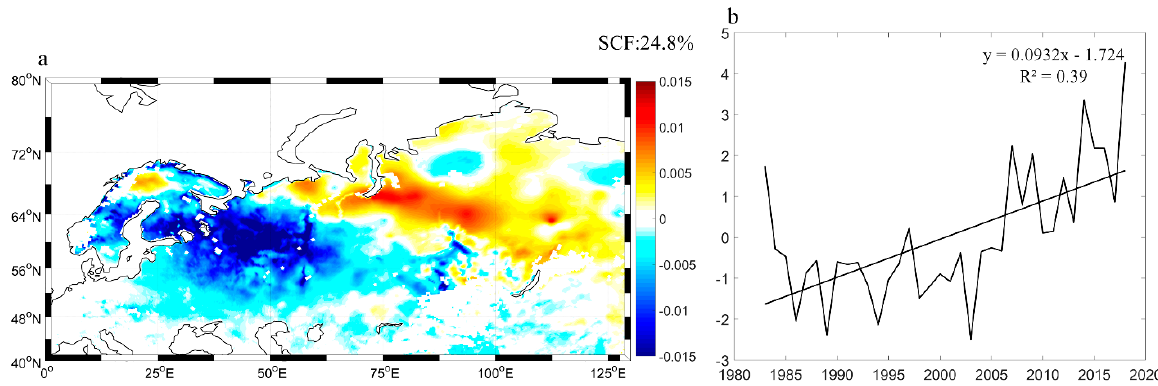
Figure 2. ( a ) Spatial characteristics of the first mode of the empirical orthogonal Function for average Eurasian winter snow water equivalent (SWE) from 1983 to 2018; ( b ) principal component time series of the first mode of the empirical orthogonal function.